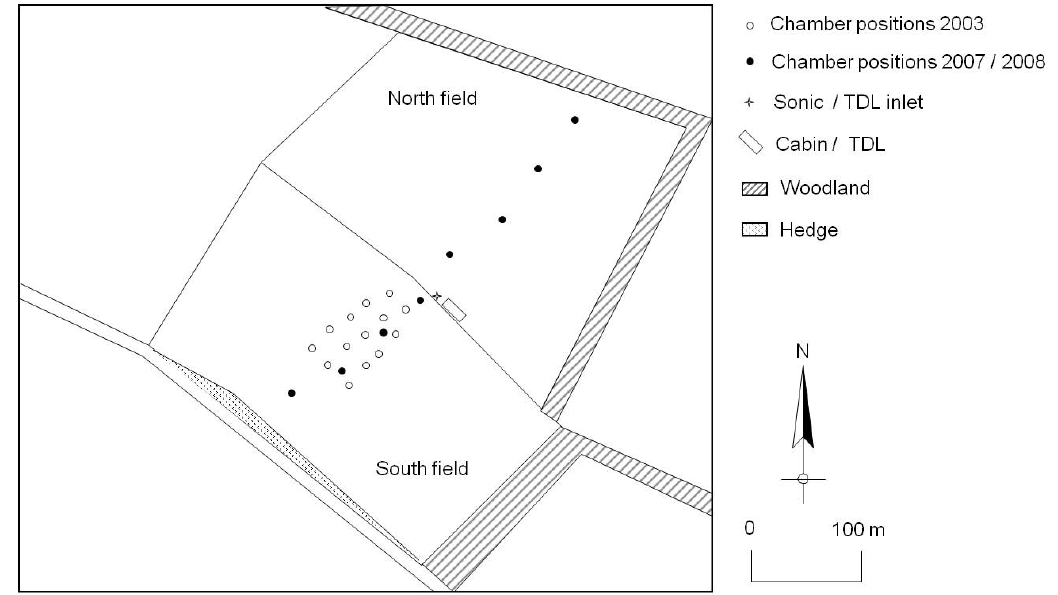
Fig. 1. Site diagram of the study field Easter Bush, showing locations of static chambers in the South and North field in 2003 and 2007/2008, micrometeorological mast (eddy covariance inlet and sonic position) and cabin (containing TDL) on the boundary of the two fields and prevailing wind directions. Table 1. Overview of comparison periods of eddy covariance and chamber N 2 O flux measurements, fertiliser application dates, amount of N applied, average air and soil temperature ( T air , T soil ) , average soil water content (SWC), average water filled pore space (WFPS) and total